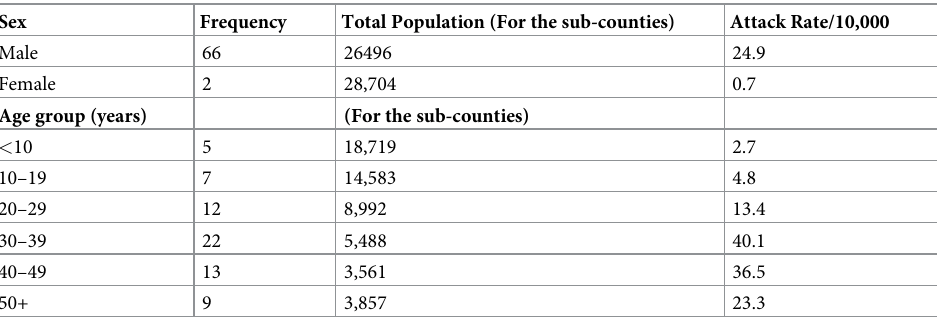
Table 1. Attack rates by age and sex during a cutaneous anthrax outbreak, (N = 68). Sex Frequency Total Population (For the sub-counties) Attack Rate/10,000 Male 66 26496 24.9 Female 2 28,704 0.7 Age group (years) (For the sub-counties) < 10 5 18,719 10–19 20–29 30–39 40.1 40–49 3,561 36.5 50+ 9 3,857 23.3 The overall attack rate was 12.3/10,000 population across the two sub-counties. Rigbo sub-county was more affected (AR = 21.9/10,000) than Rhino Camp sub-county (AR = 1.9/10,000) p < 0.0001( S4 Fig